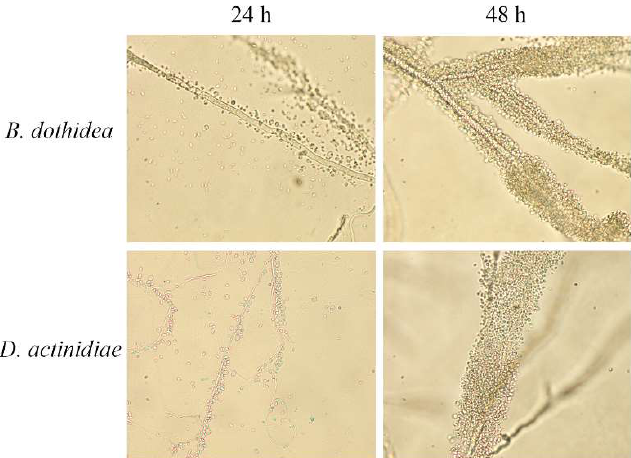
Figure 3. Adhesion of Meyerozyma guilliermondii 37 to B. dothidea and D. actinidiae (magnification: 400×) for 24 h/48 h after incubation at 25 °C.